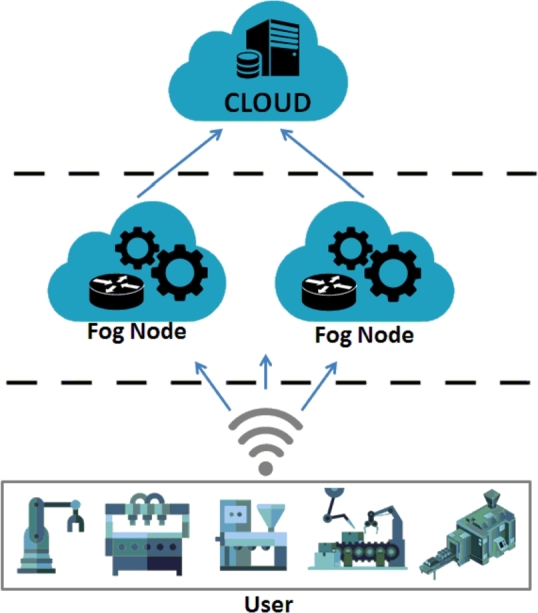
General Architecture of Fog Computing [55].